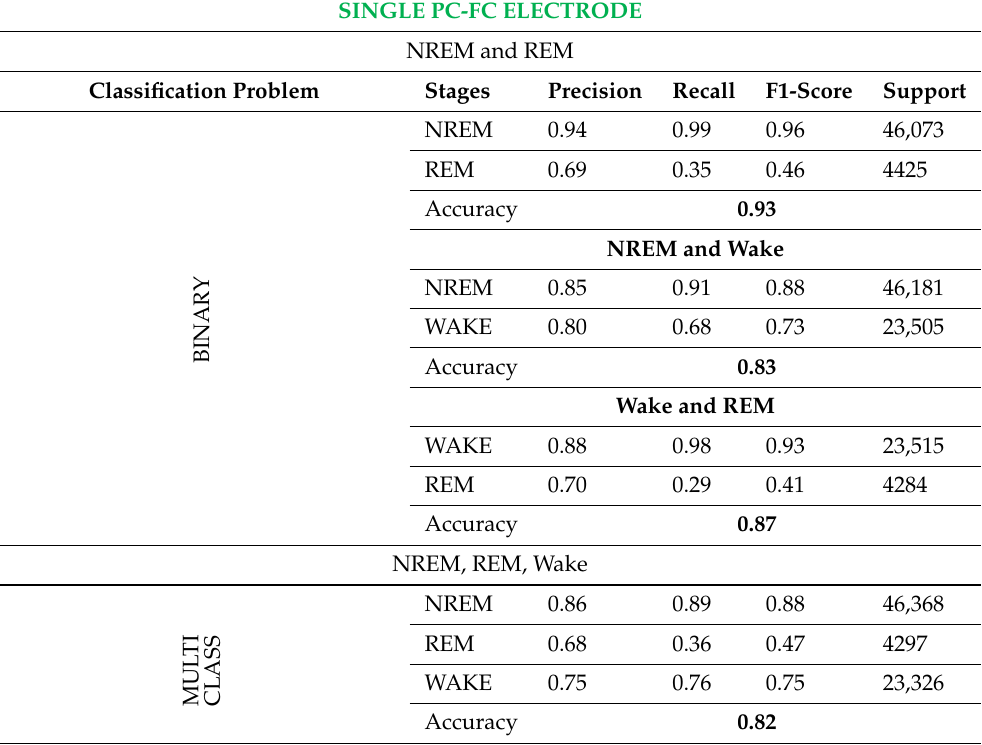
Table 5. Performance measures for binary and multiclass